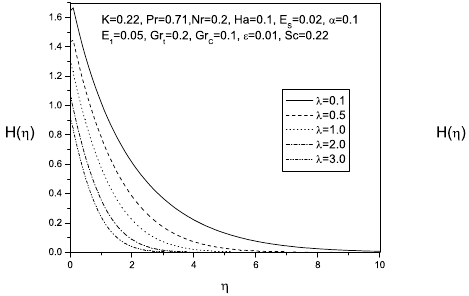
Figure 10. Variation of concentration profiles with η for different values of λ .